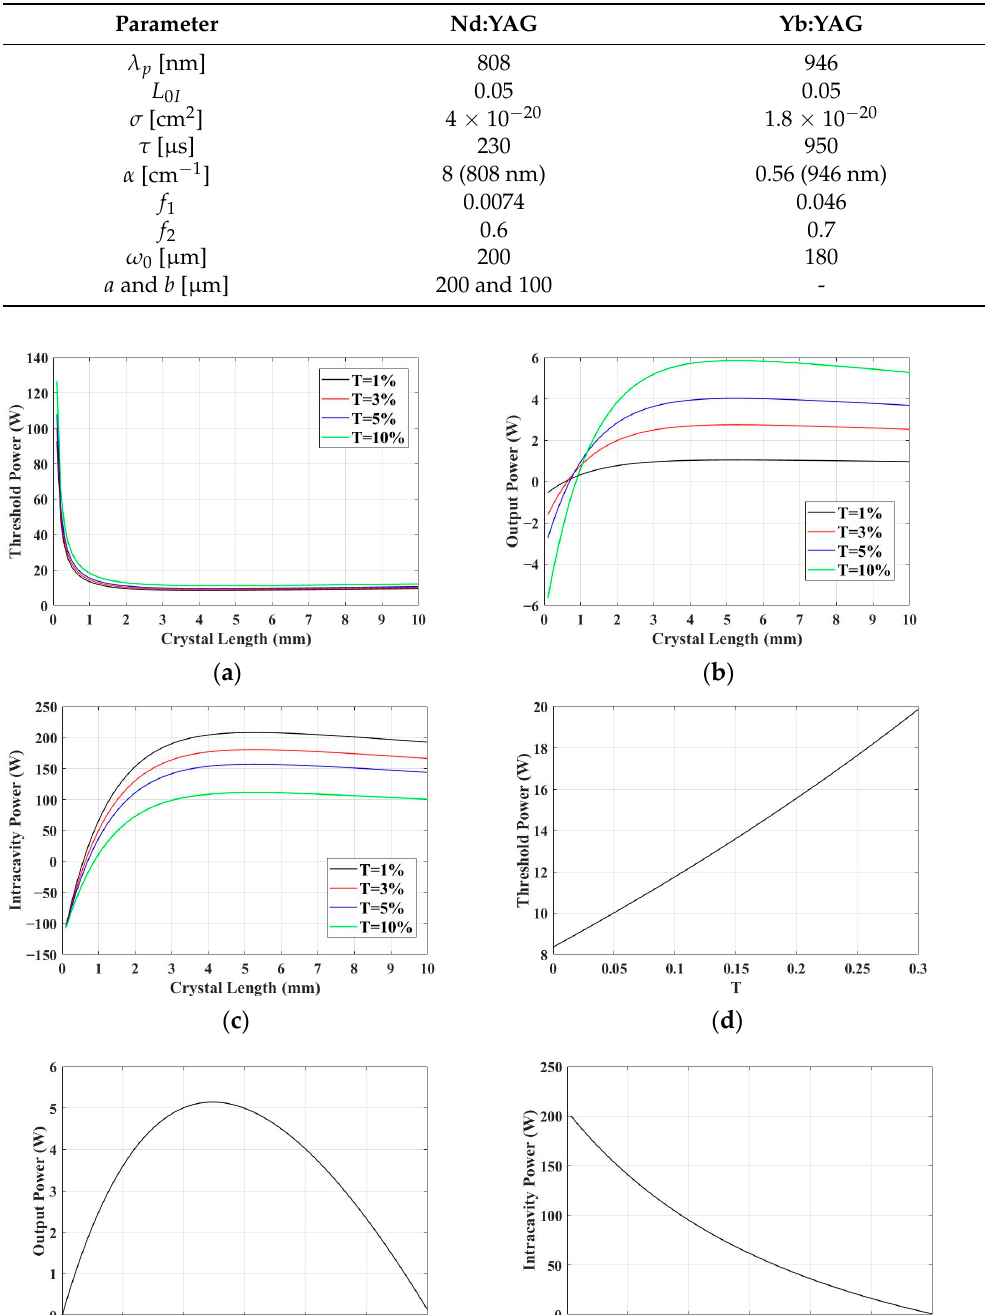
Table 1. The important parameters used in the simulation of the oscillation characteristics of the 946 and 1030 nm LG 01 mode vortex lasers [41–45].